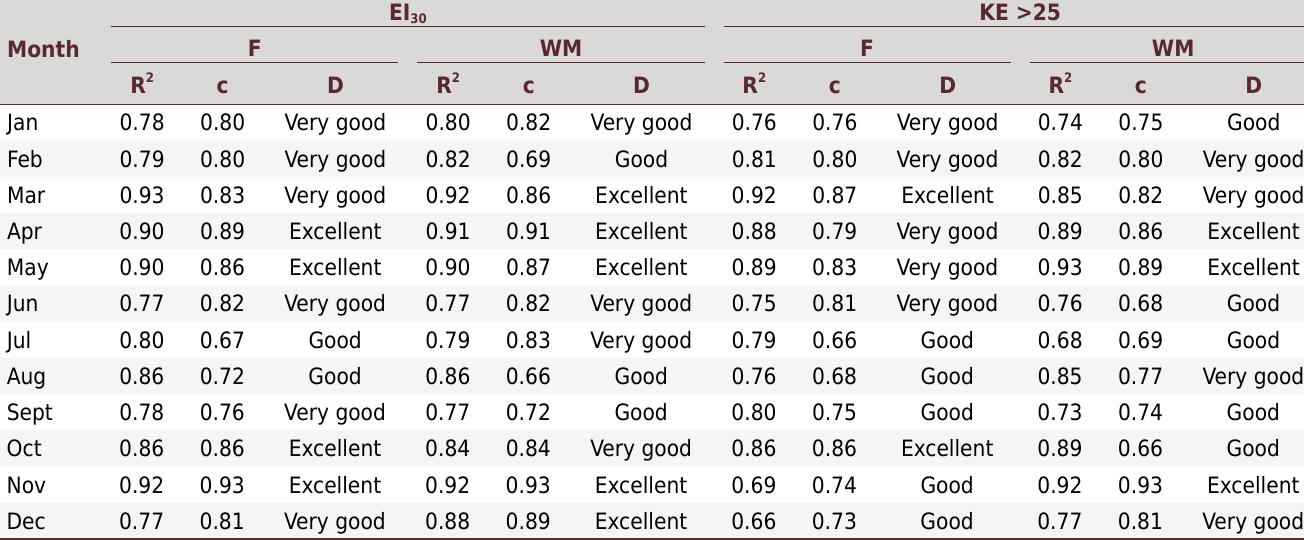
Table 3. Coefficient of determination (R 2 ), confidence index (c), and performance rating (D) of ANNs developed for the monthly estimate of rainfall erosivity according to the EI 30 and KE >25 erosivity index and the methods for obtaining kinetic energy of rainfall